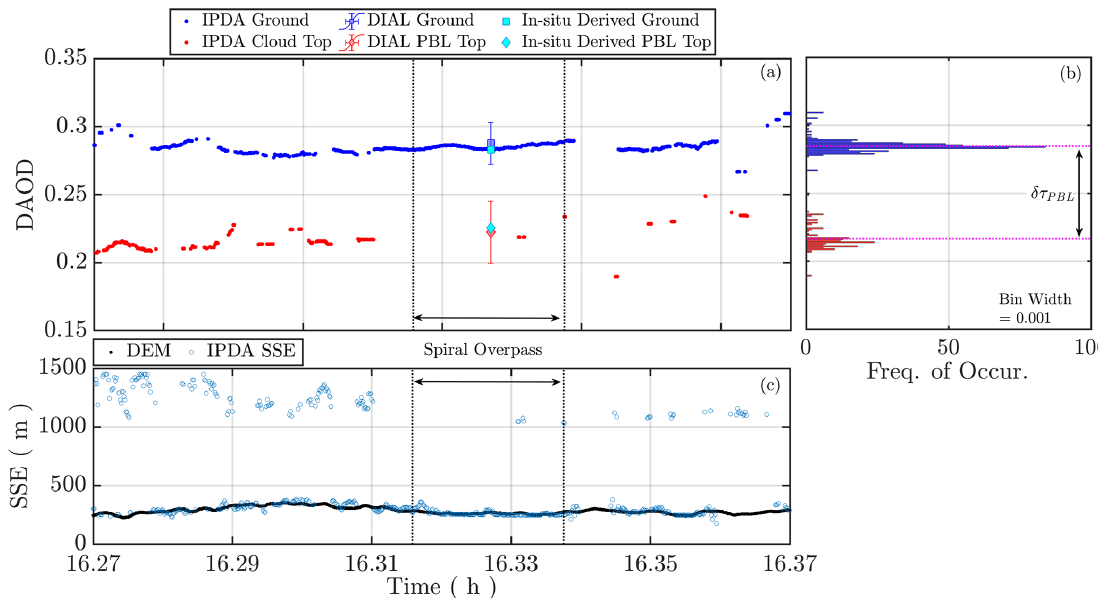
Figure 18. Summary of PBL DAOD derivation for the overpass shown in Fig. 16. (a) The column and cloud top DAOD surrounding the overpass region with DIAL-derived and in situ DAOD estimates of shown. (b) Average DAOD from cloud top and to the SSE, where histograms indicate the peak estimates from which the PBL abundances can be derived using cloud slicing, giving δτ IPDA duration of the window. (c) Compares the IPDA SSE ground and cloud top height to the